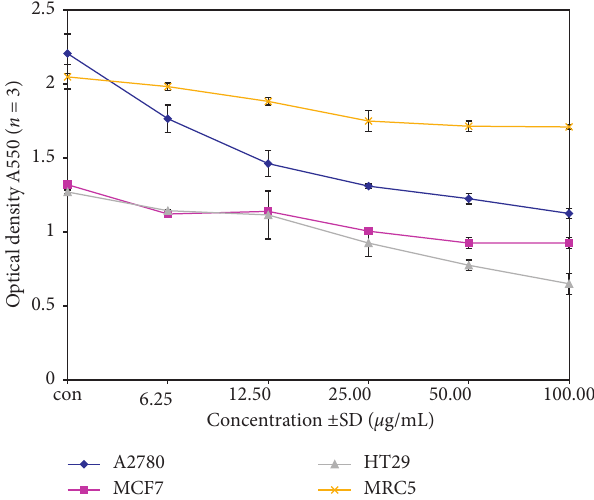
Figure 4: Cytotoxic effects of ethanol extract of S. persica fruits on A2780, MCF7, HT29, and MRC5 cells. Experiments were repeated three